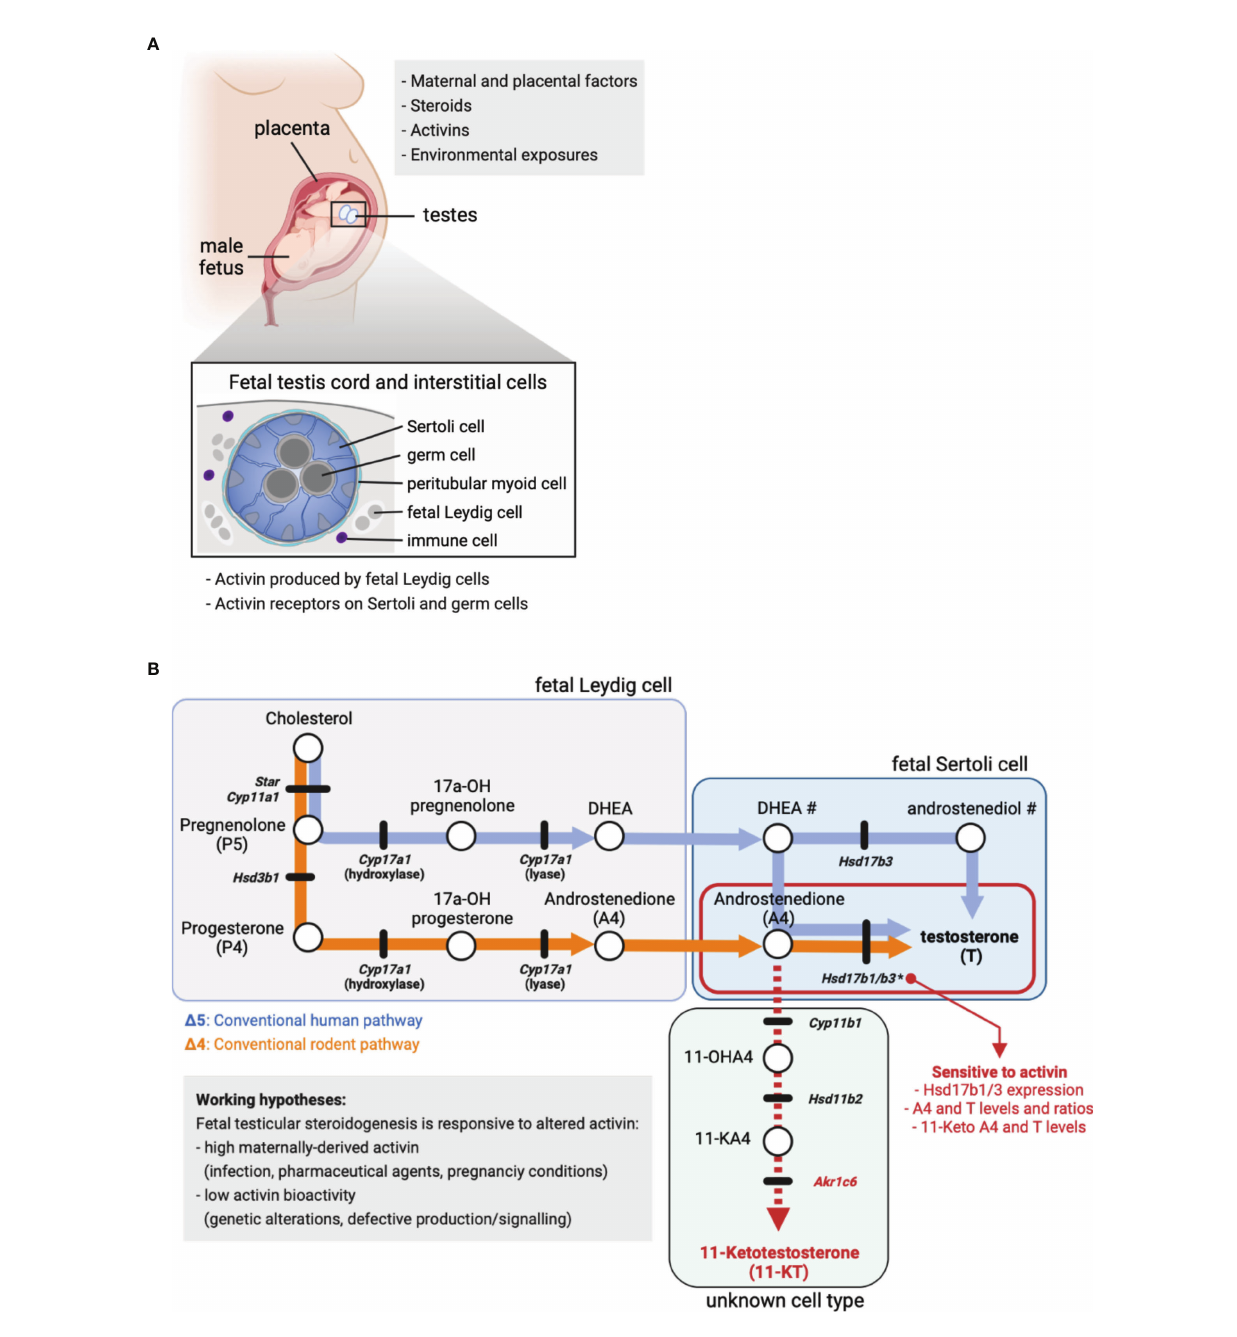
FIGURE 1 | Fetal steroid production. (A) Maternal and placental factors, exogenous steroids, activins and environmental exposures each have the potential to alter fetal steroid production. Schematic of placenta, male fetus and testes in utero . Cross-section identi fi es key fetal testis cell types in the cord (germ and Sertoli cells) and in the surrounding interstitium (fetal Leydig, peritubular and immune cells). Activin is produced by fetal Leydig cells and signals via speci fi c cell surface receptors present on Sertoli and germ cells. (B) Simpli fi ed summary of the conventional steroidogenic pathway in human ( D 5, blue line/arrows) and rodent ( D 4, orange line/ arrows) fetal testes. The 11-Keto androgen pathway is indicated (red dashed line), as are 11-Hydroxyandrostenedione (11-OHA4), 11-Keto androstenedione (11- KA4) and 11-Ketotestosterone (11-KT). The cellular site of steroid production is indicated, where known. Circles denote cholesterol and steroids, while black lines indicate genes encoding enzymes involved in the conversion of one steroid to the next. Mouse nomenclature has been used throughout; Table 1 lists human nomenclature. # indicates the local site(s) of DHEA and androstenediol production in human is unclear. * indicates activin A-responsive genes; the ratio of A4 to T in mouse fetal Sertoli cells is dose-dependently reduced by low levels of Hsd17b1 and Hsd17b3 expression driven by altered activin A bioactivity. In these testes, excess A4 is associated with higher levels of 11-keto